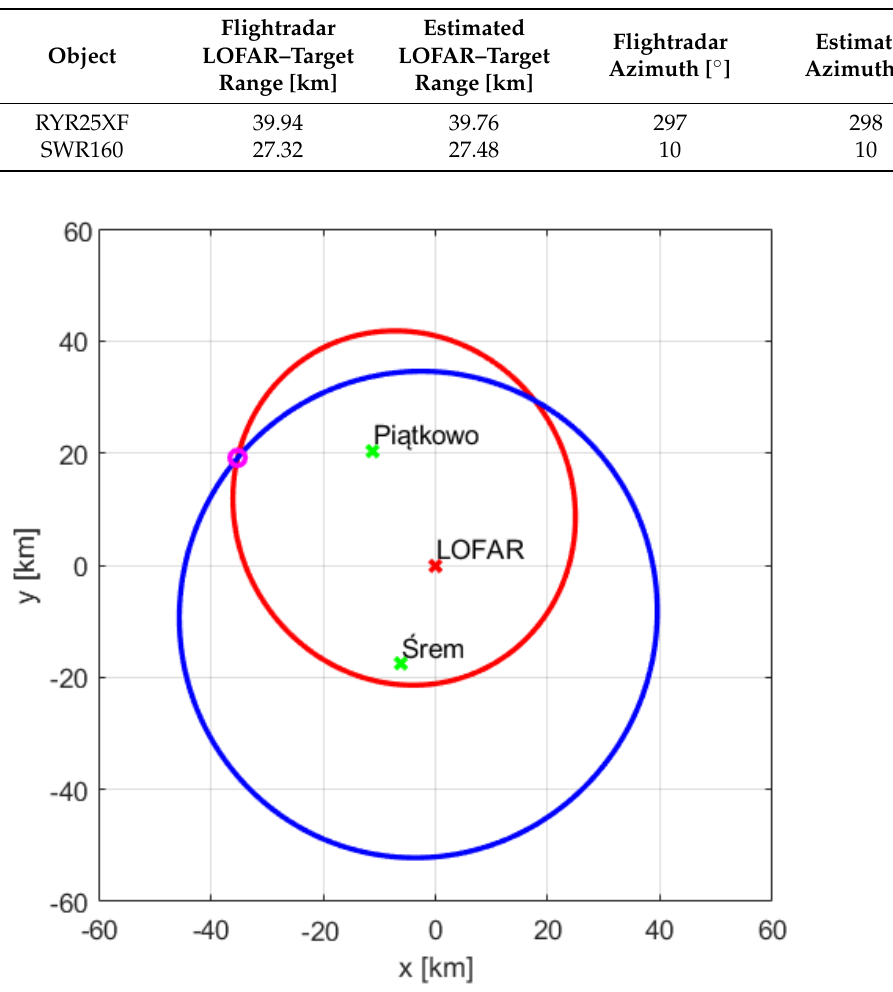
Figure 13. Intersection of ellipses for